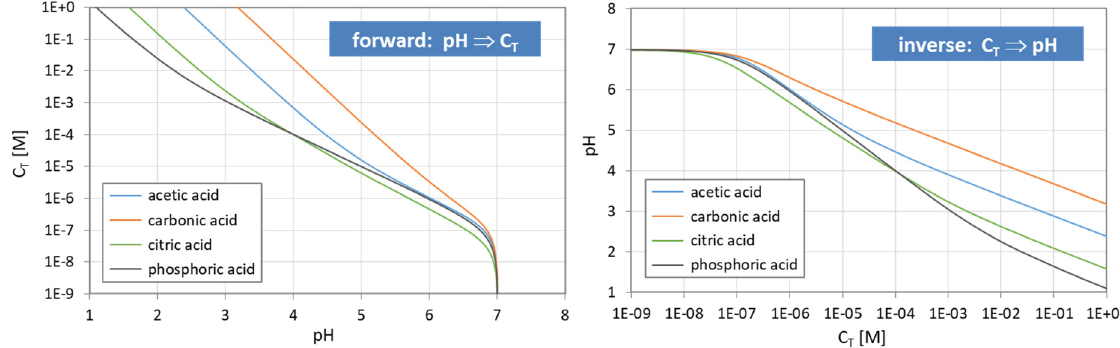
Figure 11. Functional relationship between pH and C T for four acids (and n = 0). ( Left ): calculation based on Equation (43); ( right ): calculation based on the polynomial (44).